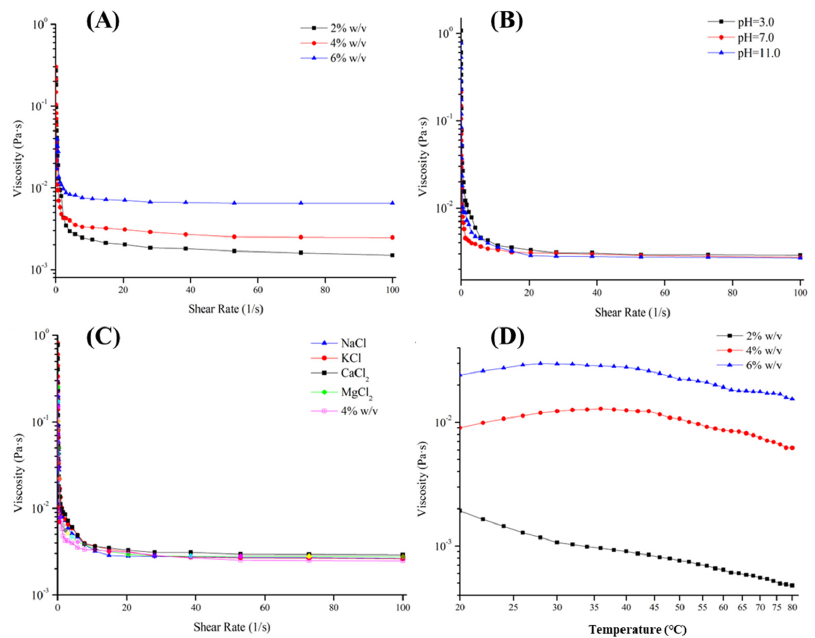
Figure 6. Effects of polysaccharide concentration ( A ), pH value ( B ), metal ion ( C ) and temperature ( D ) on the apparent viscosity of EPS − 1 from Lc. citreum 1.2461.